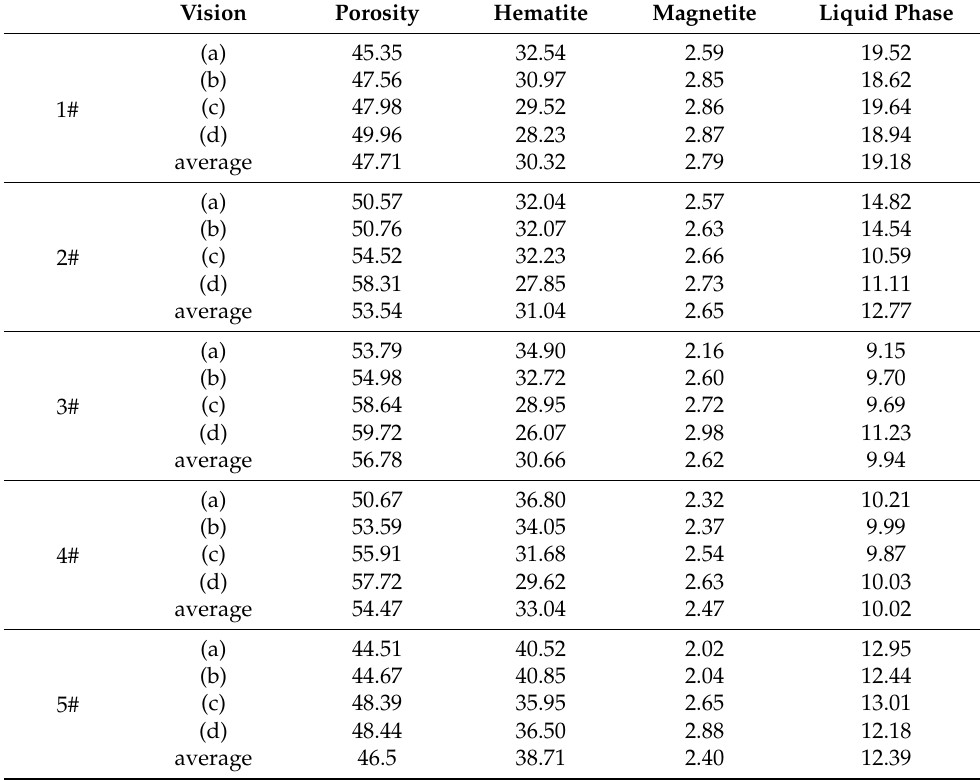
Table 6. Generation of each phase of roasted pellets with different basicity/%. Vision Porosity Hematite